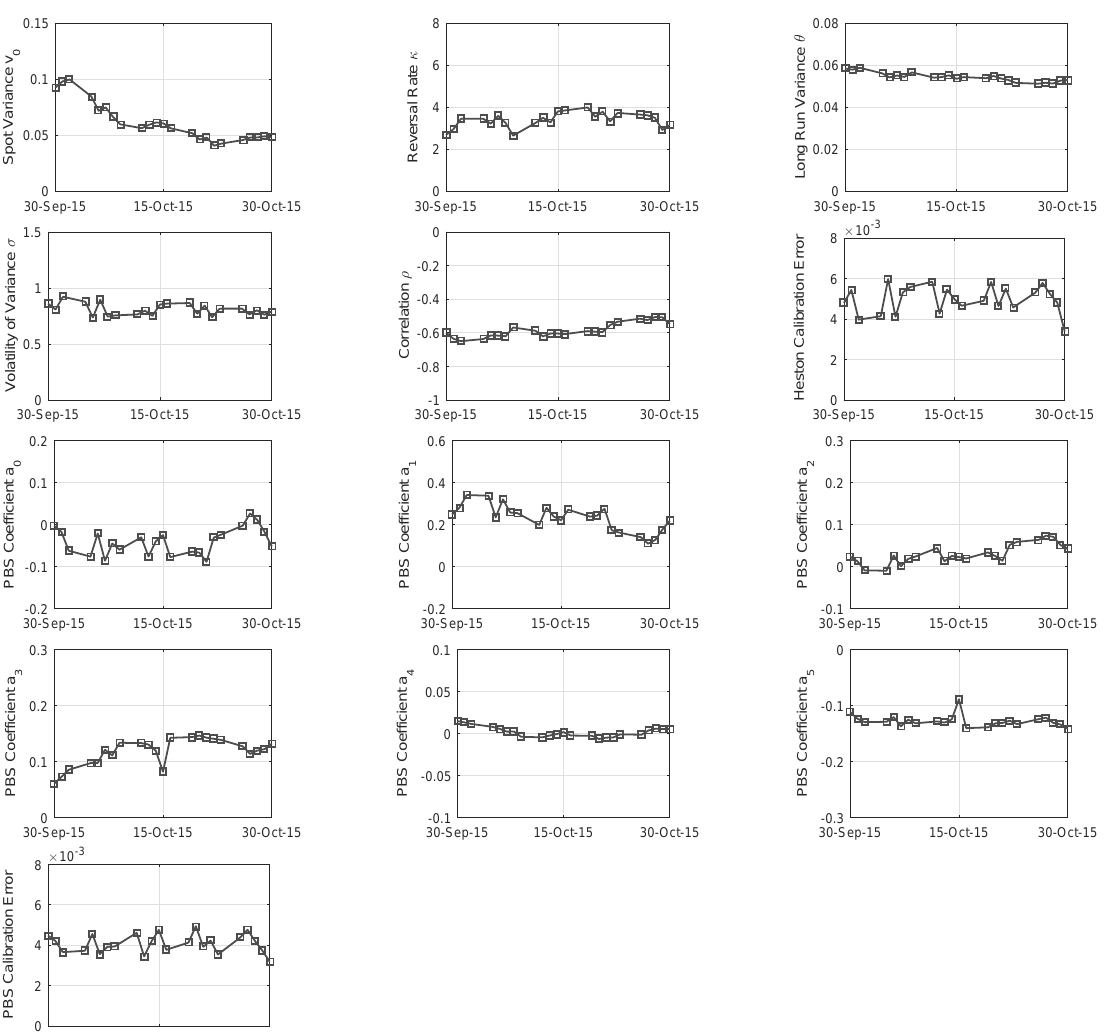
Figure 4. Calibrated Heston and Practitioner Black-Scholes (PBS) Model Parameters, and In-Sample Fit. Model parameters and the root mean squared errors of implied volatility (IVRMSE) in-sample fit are reported for the Heston and PBS model. Each model is sequentially calibrated to end-of-day DAX index option quotes between 30 September 2015 and 30 October